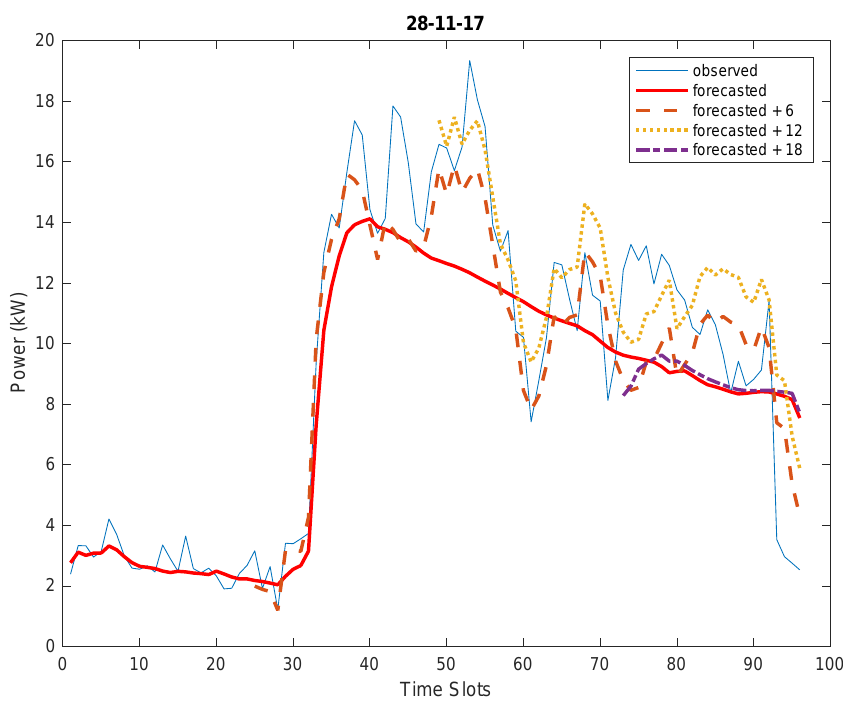
Figure 16. Pilot system: School (Palo del Colle), Day: 28 November 17. Daily forecasts vs. observed power